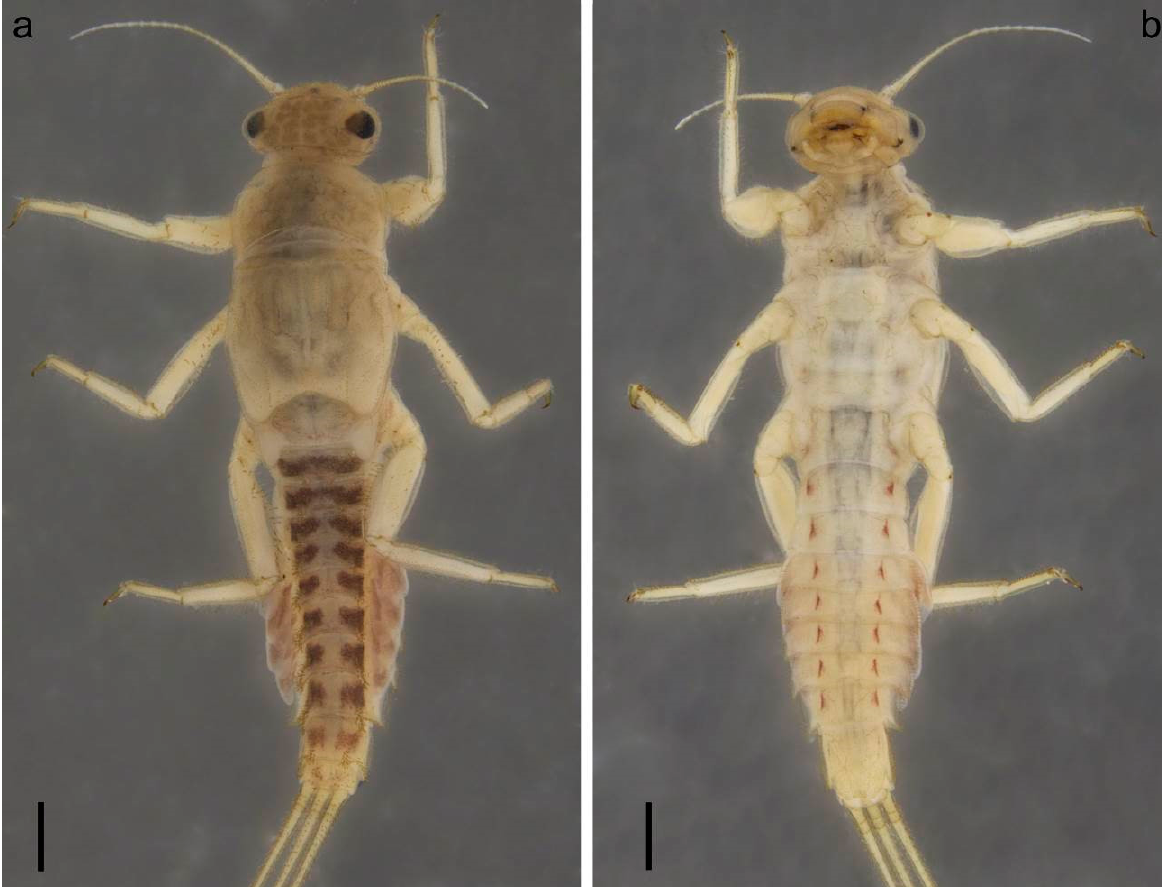
Figure 1. Larva of Serratella leonidi Martynov & Palatov, sp. nov. , holotype. ( a ) Habitus, dorsal view, ( b ) habitus, ventral view. Scale bar: 0.5 mm.